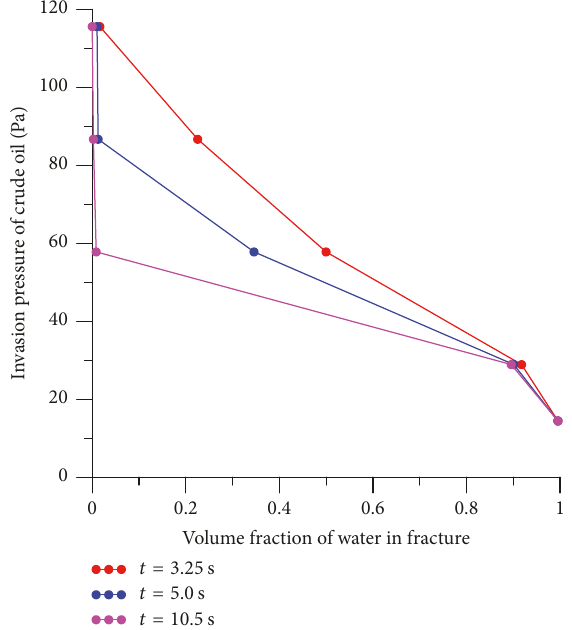
Figure 7: Relationship curves of the invasion pressure of crude oil and the volume fraction of water in the fracture at different